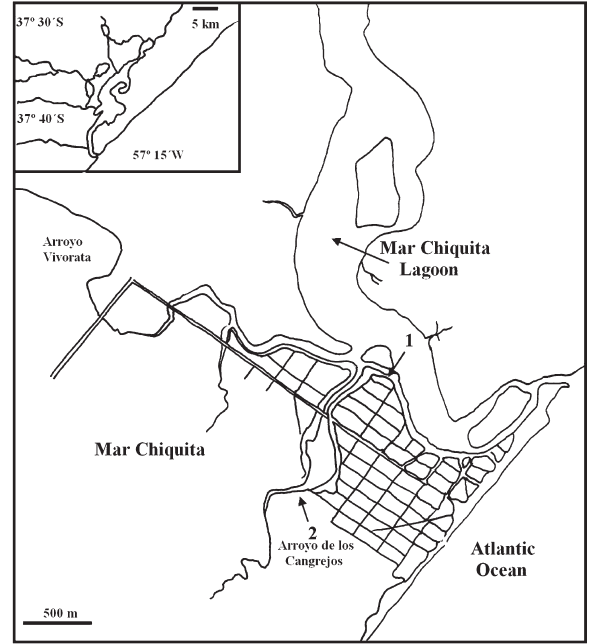
Fig . 1. – Neohelice granulata. Study area with sampling sites: (1) mudflats; (2) salt marsh. inset: geographical position of mar Chiquita